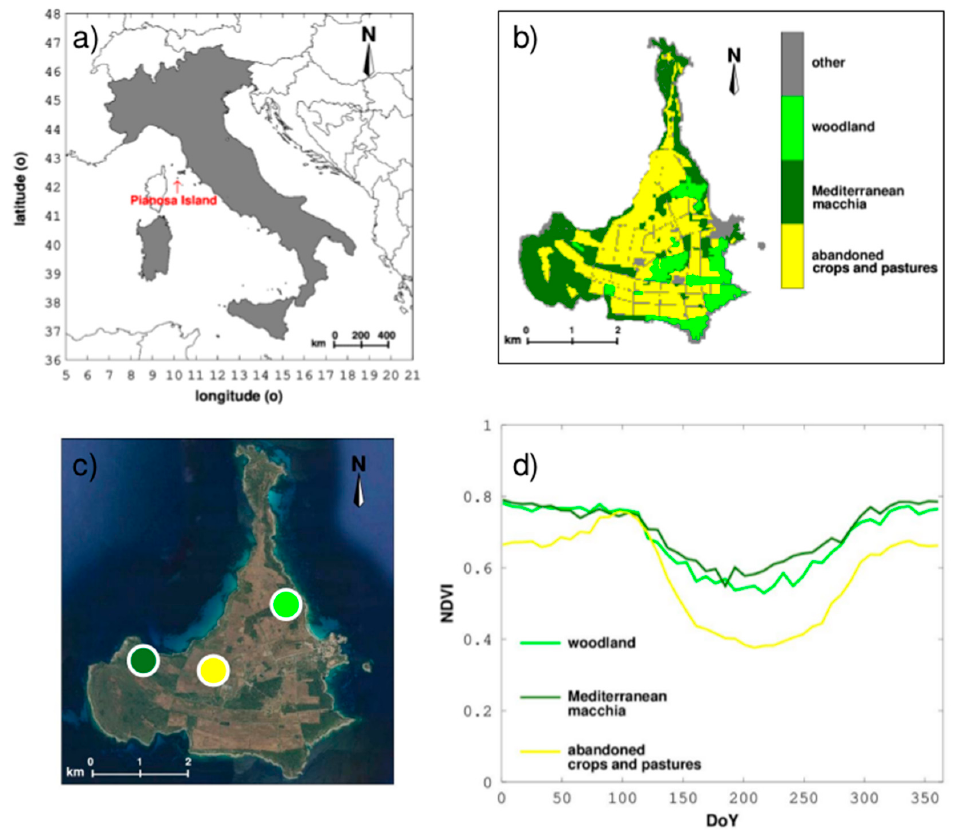
Figure 1. ( a ) Geographic location of Pianosa Island, Italy. ( b ) Land cover classes of Pianosa Island. ( c ) Google Earth image of Pianosa Island with the indicated three representative areas for woodland (light green circle), Mediterranean macchia (dark green circle), and abandoned crops and pastures (yellow circle). ( d ) Example of seasonal variation of Moderate Resolution Imaging Spectroradiometer (MODIS) normalized difference vegetation index (NDVI) values in the three types of ecosystems identified with a colored circle in Figure 1c. Each data point is the interannual average of the MODIS NDVI data among the 17 years of the 2000–2016 period (MODIS product type Mod44 / Myd44, data source Terra and Aqua, Global Agriculture Monitoring Project,